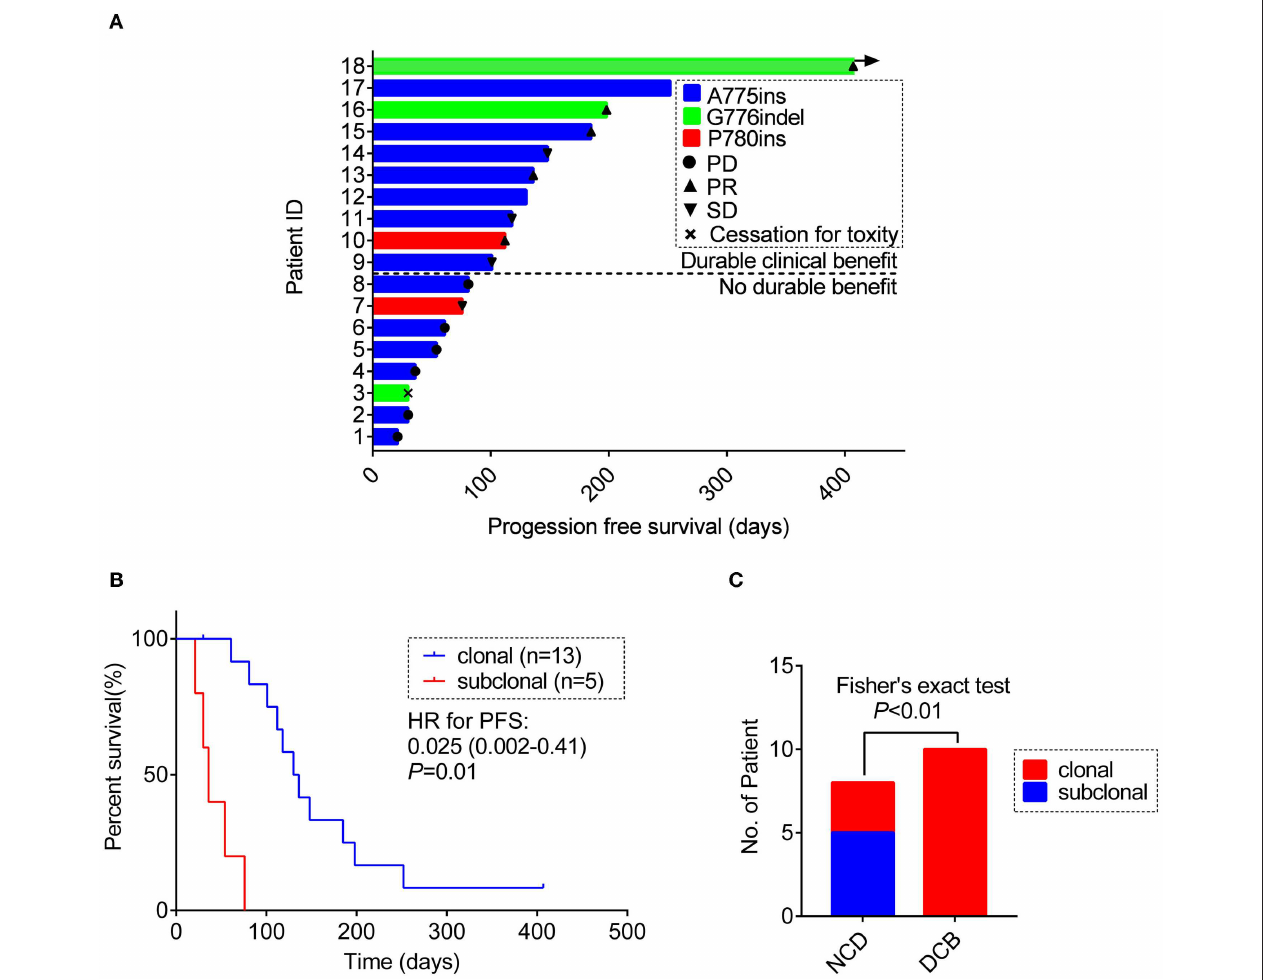
FIGURE 3 | (A) Swimming plot visualizing the response details for afatinib in each patient ( n = 18). (B) Kaplan-Meier comparing PFS for ERBB2ex20ins as clonal or subclonal variant ( p -values determined by multi-variant regression analysis and HR with 95% CI are shown). (C) The distribution of ERBB2 clonality status between the DCB group and the NDB group. DCB, durable clinical benefit; NDB, no durable benefit.